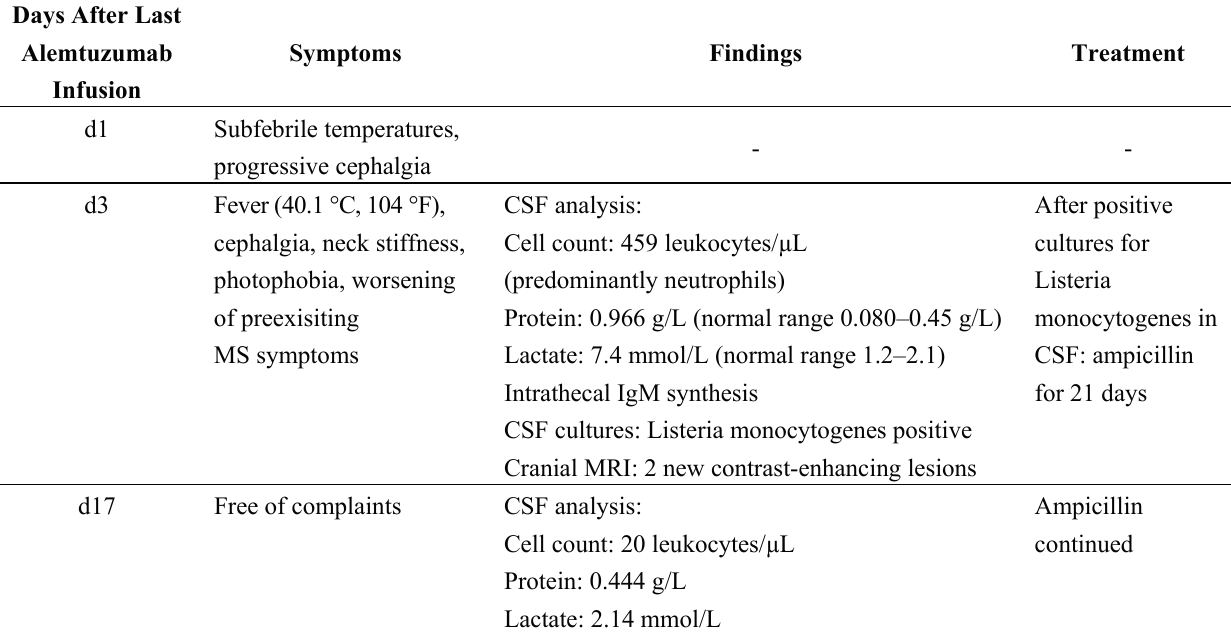
Table 2. Clinical symptoms and CSF findings in case